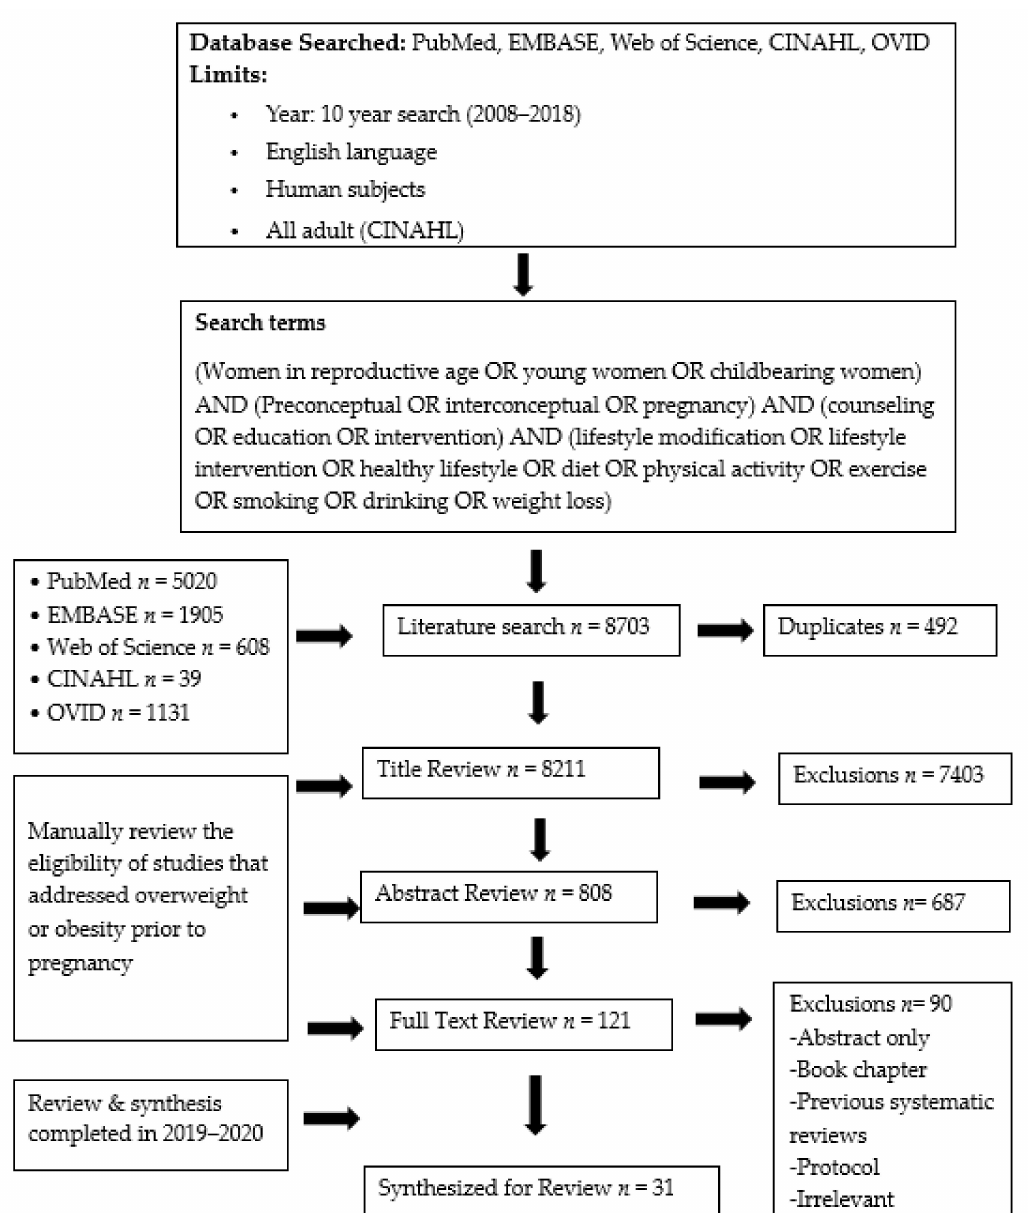
Figure 1. PRISMA (The Preferred Reporting Items for Systematic Reviews and Meta-Analyses) Flowchart to select arti- cles